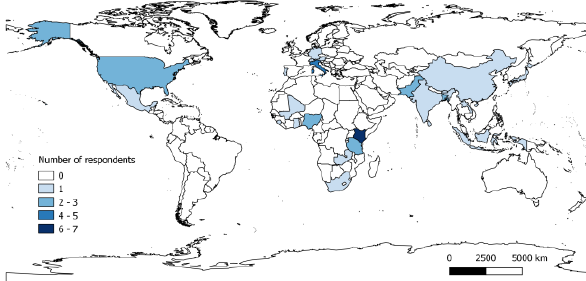
Figure 2. Distribution of the respondents to the first survey Most of the respondents (92%) stated that they are familiar with LC maps and 85% of them have used LC maps in their research or professional work. In terms of the LC maps used, 1/3 of the respondents have used LC maps derived from Landsat imagery;